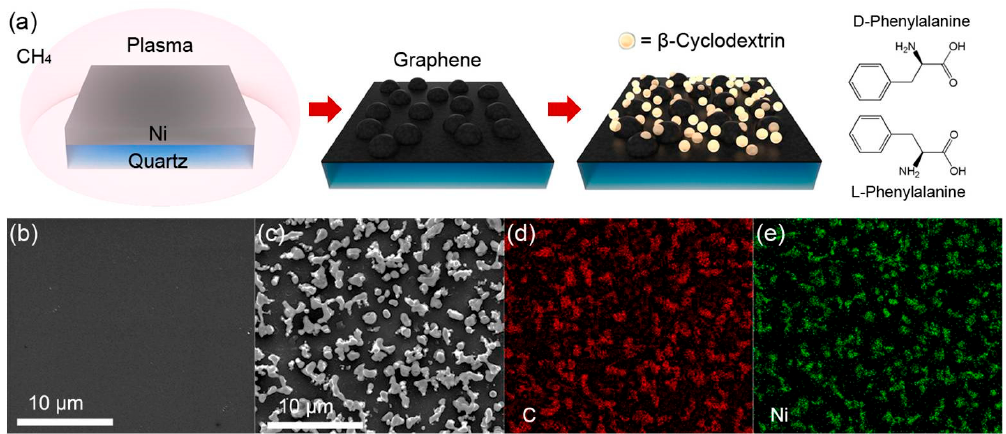
Figure 1. ( a ) Schematic diagram of β -cyclodextrin ( β -CD) / Ni / G enantiorecognition biosensor fabrication. ( b ) SEM images of as-deposited Ni layer ( c ) SEM images of the Ni / G electrode. ( d , e ) The energy-dispersive spectroscopy (EDS) mappings of C and Ni of ( c ).